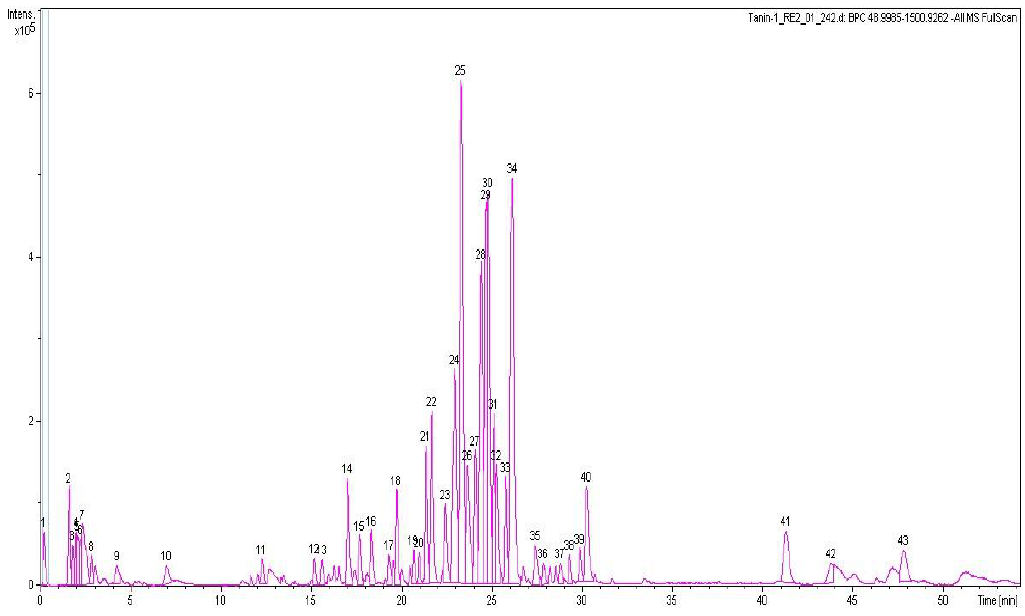
Figure 5. Base peak chromatogram of compounds in CAB obtained using HPLC-QTOF-MS in the negative mode. Table 1. Profile of major bioactives detected in CAB by HPLC-QTOF-MS. Peak